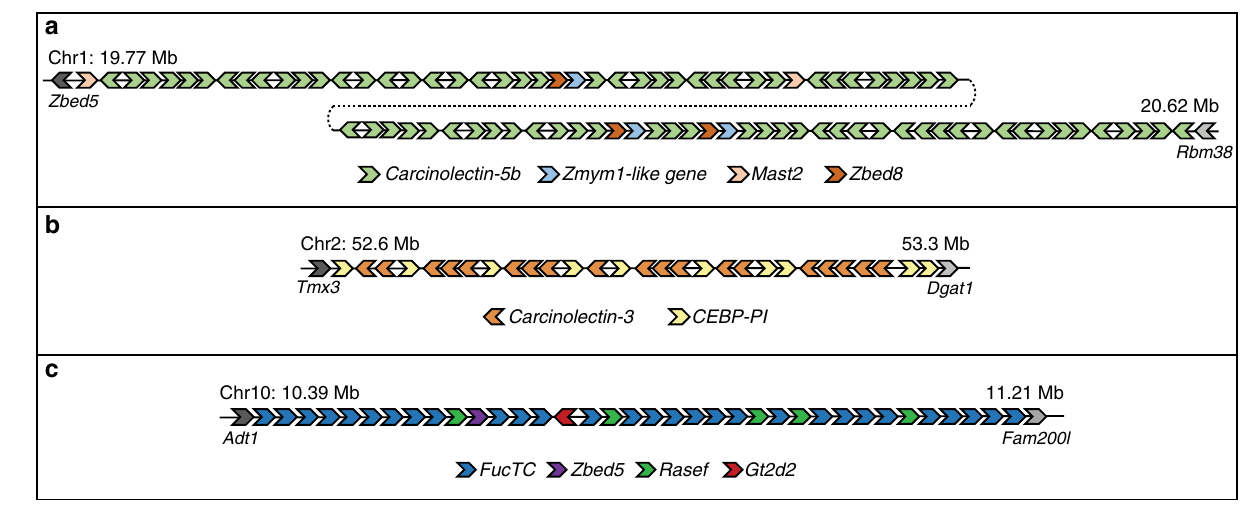
Fig. 9 Innate immune system-related tandem gene clusters in the mangrove HSC genome. a Carcinolectin-5b locus, b Carcinolectin-3 / CEBP-PI locus and c FucTC locus. Carcinolectin is the mangrove HSC homolog of tachylectin that was previously identi fi ed in the tri-spine HSC. The fi gure is based on manual annotation of these loci which helped to identify more genes than those predicted by MAKER